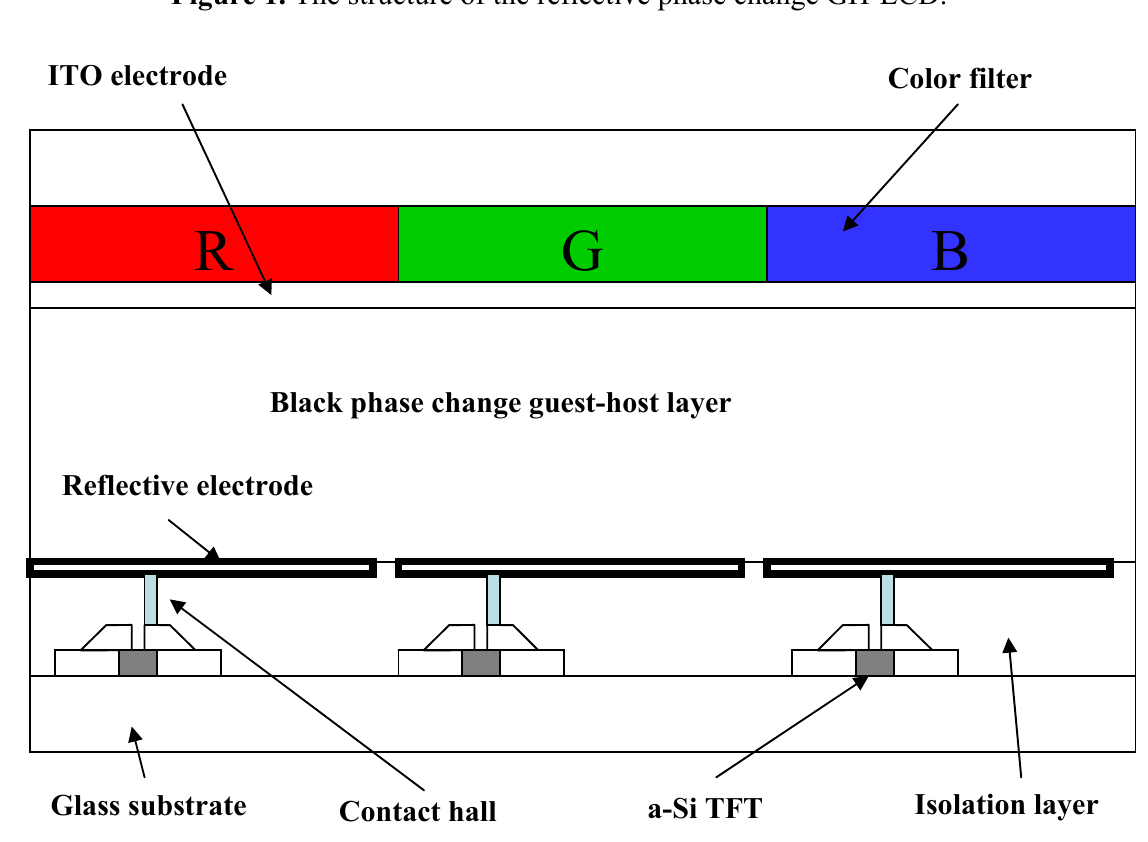
Figure 1. The structure of the reflective phase change